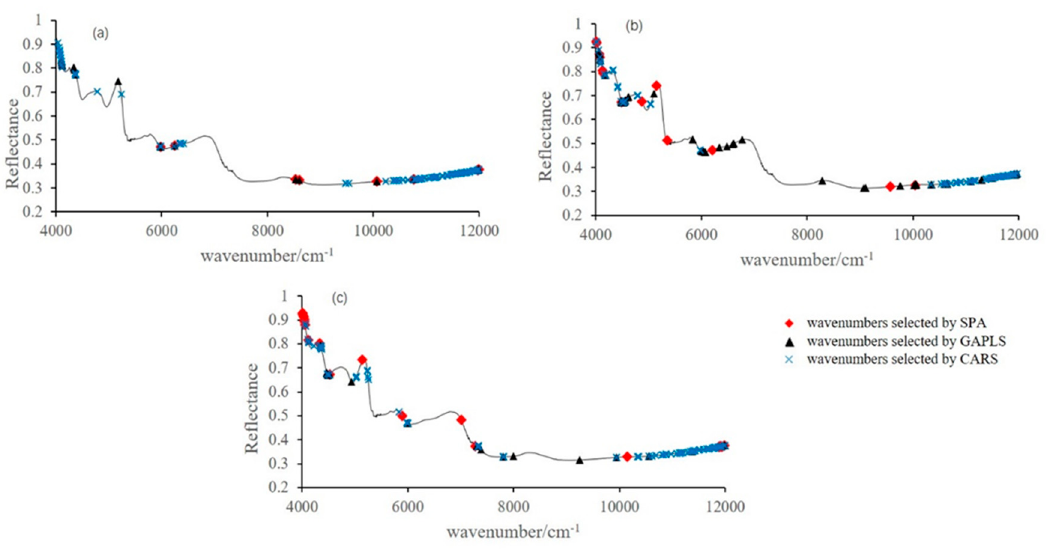
Figure 2. Sensitive variables selected by different methods for prediction of ( a ) chlorogenic acid, ( b ) luteoloside, and ( c ) 3,5 ‐ O ‐ dicaffeoylquinic acid.